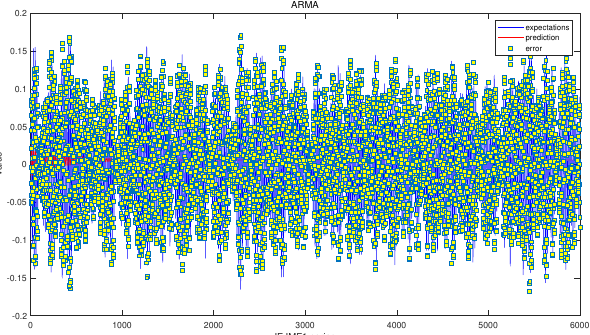
Figure 4. Prediction result of ARMA model for IF IMF1 time series.